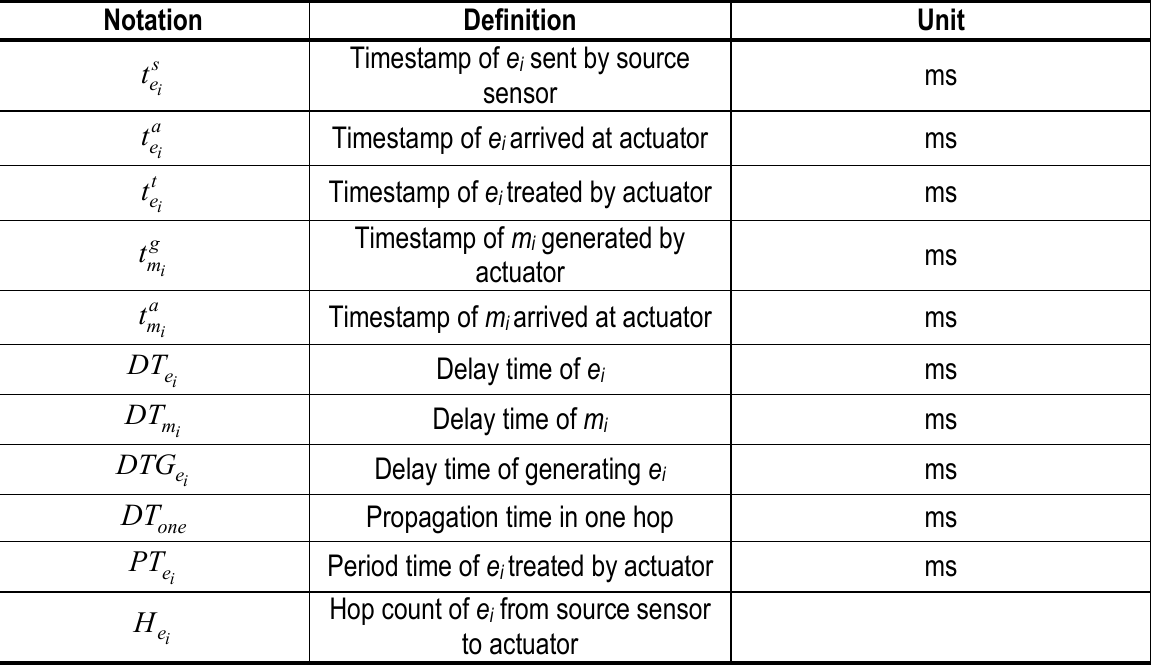
Table 1. Notation in FTEOCCAC